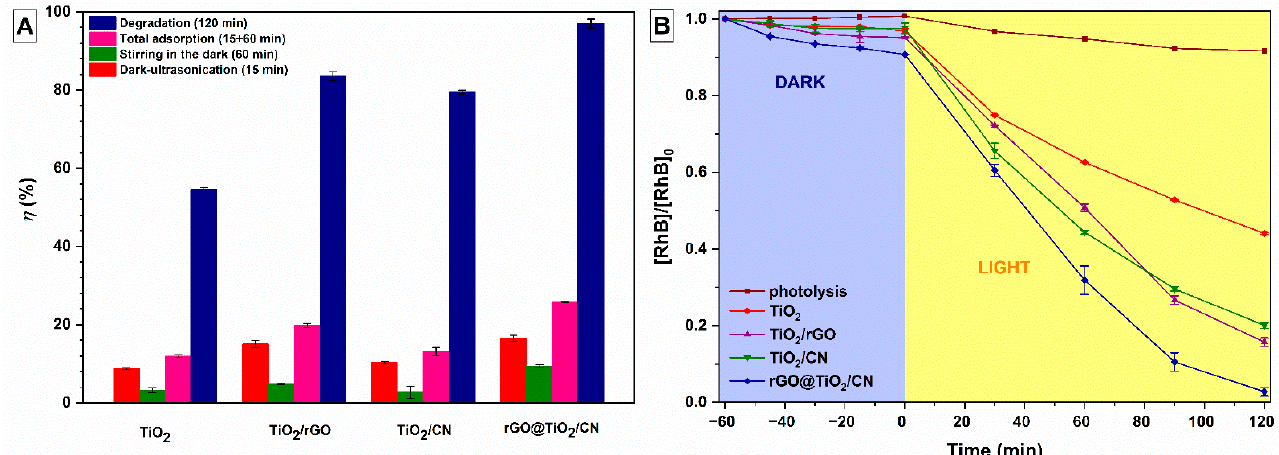
Figure 6. ( A ) The percentage of adsorption for RhB dye in aqueous solution (Milli-Q water) after ultrasonication (15 min)— red, stirring in the dark (60 min)—green and total dark adsorption (15 + 60 min)—pink, and photocatalytic degradation efficiency (after 120 min)—blue under solar-like irradiation. ( B ) Photocatalytic degradation of RhB aqueous solution (Milli-Q water) in the dark and under light irradiation. Table 2. The values of the first-order rate constant ( k ) and efficiency ( η ) of RhB dye aqueous solution photodegradation by prepared photocatalysts.